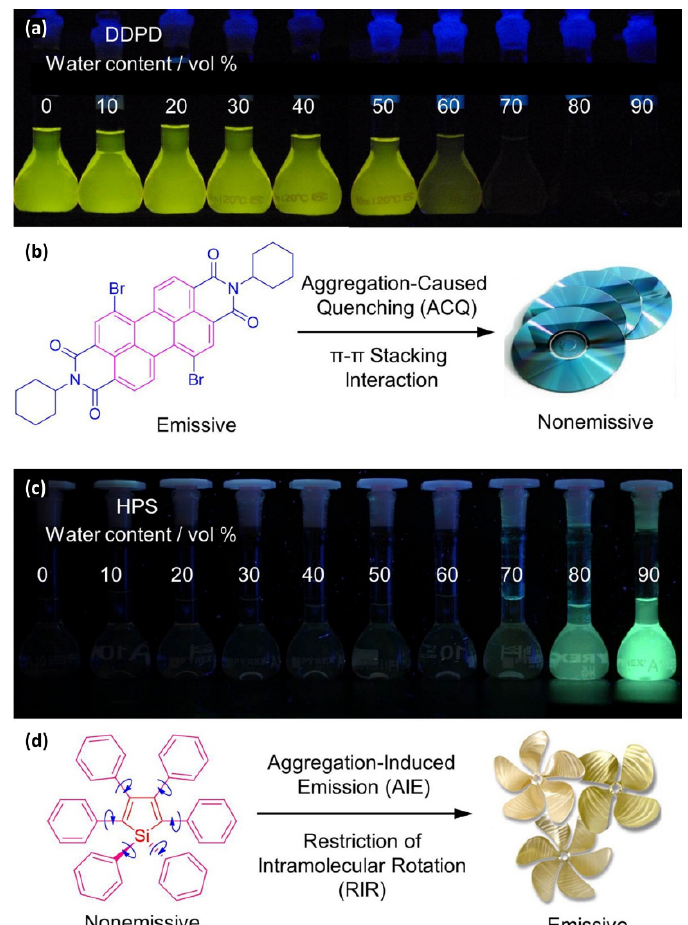
Figure 3. Fluorescent digital photographs of ( a ) fluorescein and ( c ) hexaphenylsilole (HPS) solutions with different bad solvent fractions. ( b ) Fluorescein molecules are disk-shaped and become non- emissive when forming aggregates where a strong π−π interaction quenches the emission. ( d ) HPS molecules are propeller-shaped and become highly emissive when forming aggregates where the intramolecular rotation is restricted. Reprinted with permission from Ref. [155] . Copyright 2018, American Chemical Society.